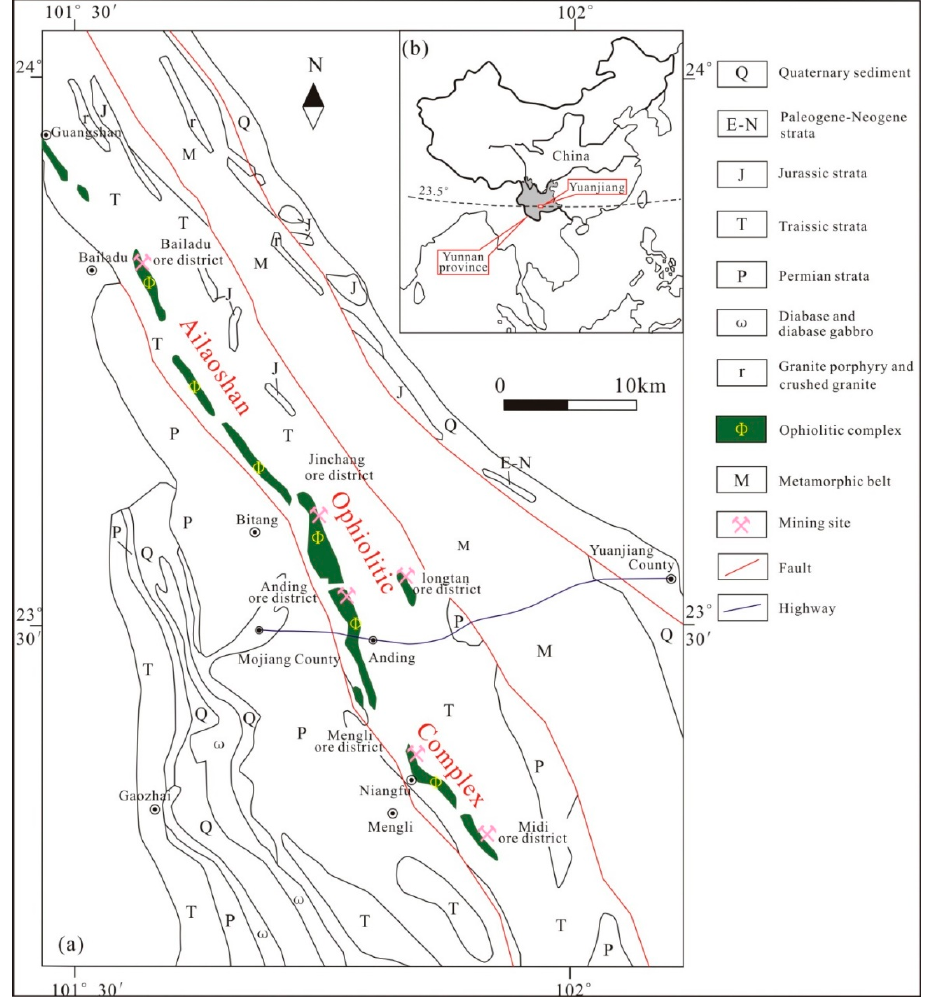
Figure 1. Simplified geological map of the Yuanjiang region, Yunnan Province, SW China, showing the location ( a ) and main geological context ( b ) of the study area.